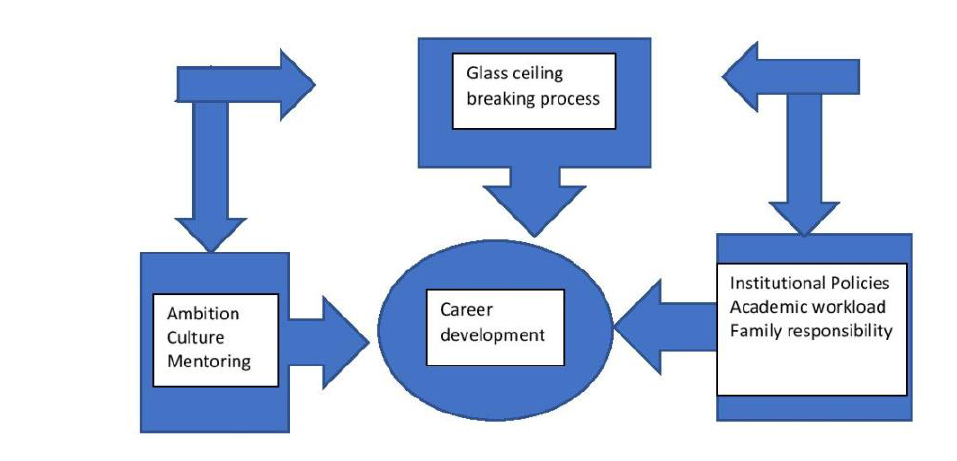
Figure 1: Career development conceptual model; Source: